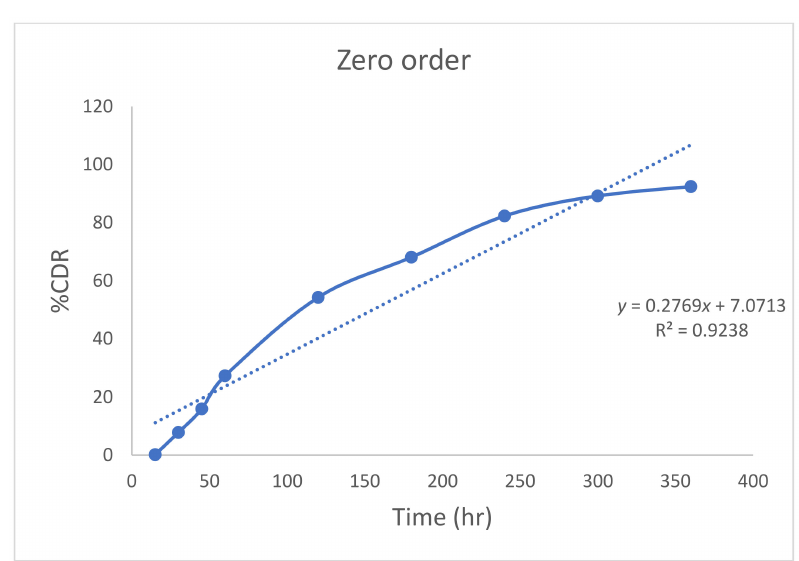
Figure 5. Zero-order release kinetics for